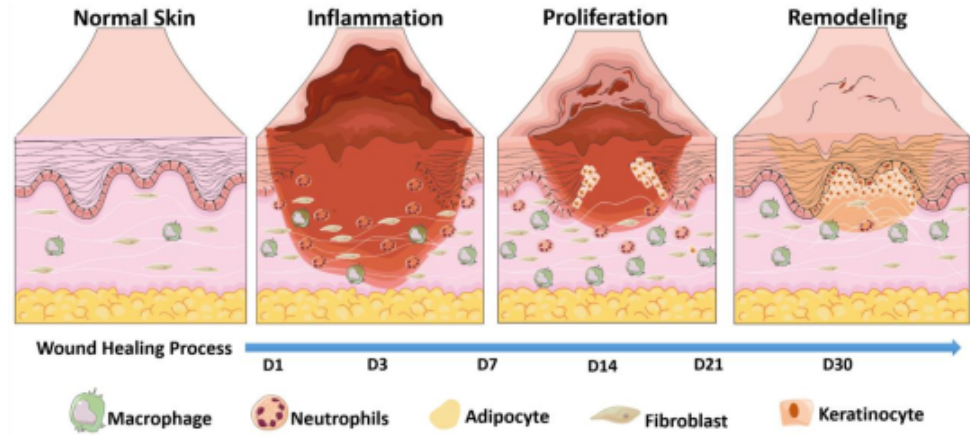
Figure 3. The key phases of wound